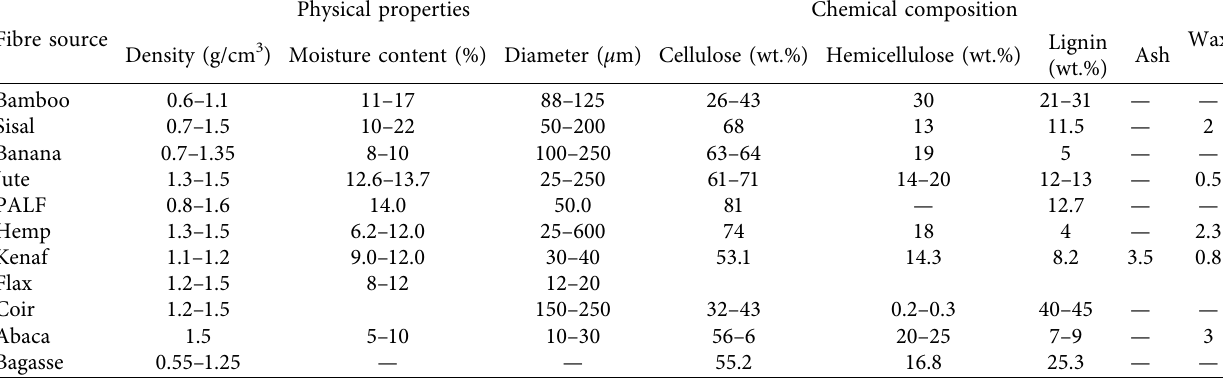
Table 2: Chemical composition and physical characteristics of common natural fibres [47–53].